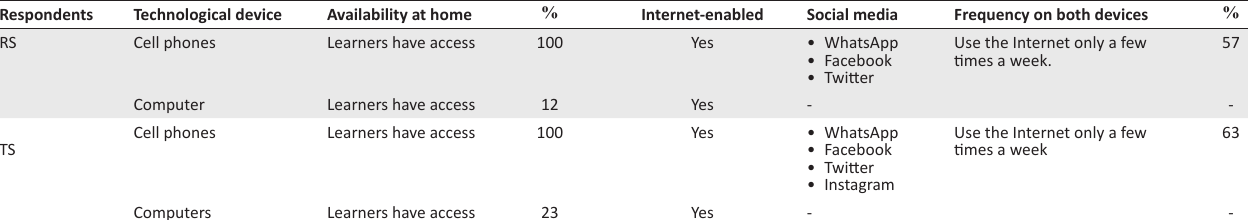
TABLE 1: Availability of resources at